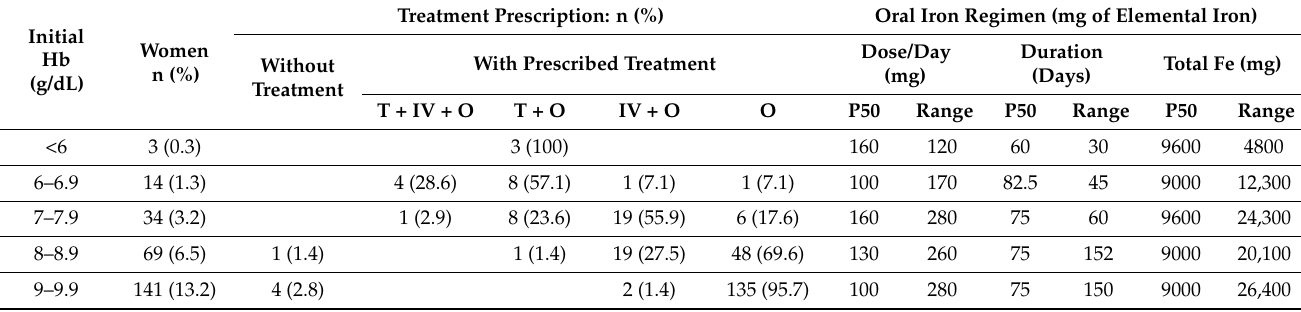
Table 2. Treatment for anemia in the postpartum period: women treated, types of treatment and prescribed oral iron